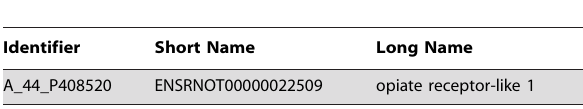
Table 8. Upregulated genes specifically involved in pain transmission in VSL # 3-treated NMS rats in comparison with normal